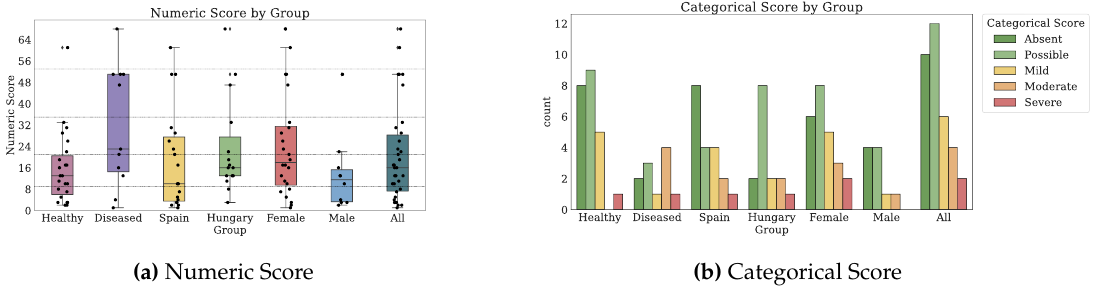
Figure A5. Scores for Anxiety and Depression (GADS). Dotted markings delimit levels of the categorical score.